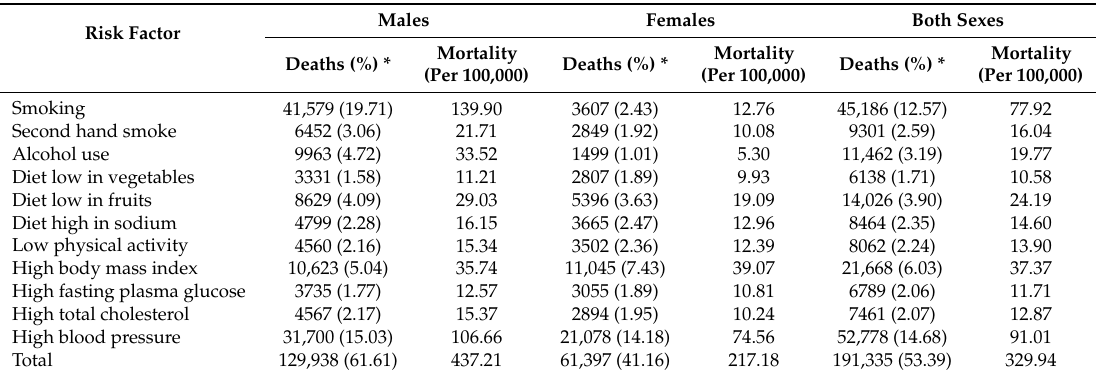
Table 2. Deaths attributed to 11 risk factors in Hubei Province in 2013.